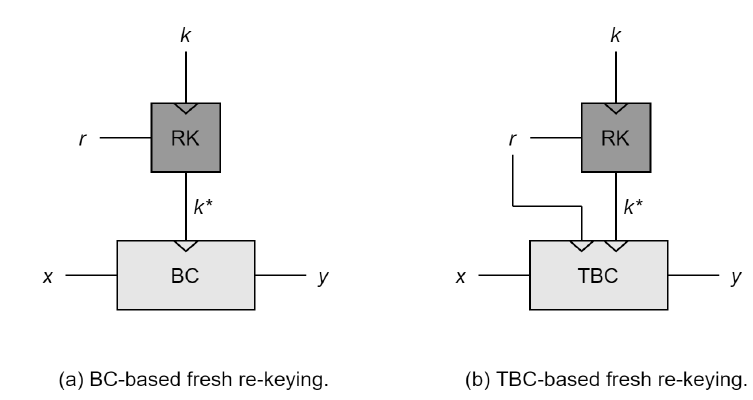
Figure 1: Fresh re-keying schemes: the dark grey blocks must be strongly protected against side-channel attacks, the light grey blocks only require weak